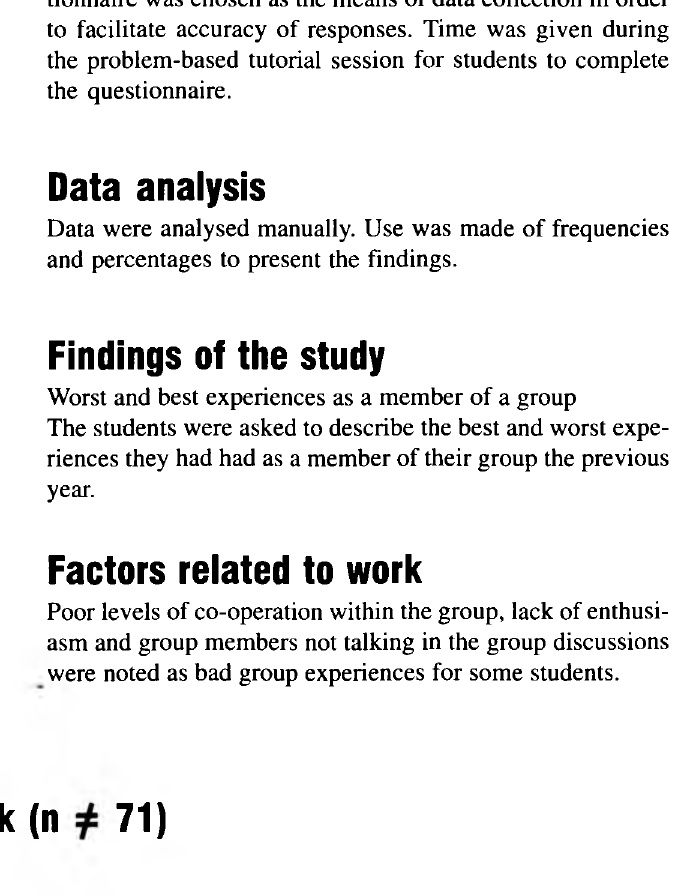
Table 1 : Irritating aspects of group work (n 7 1